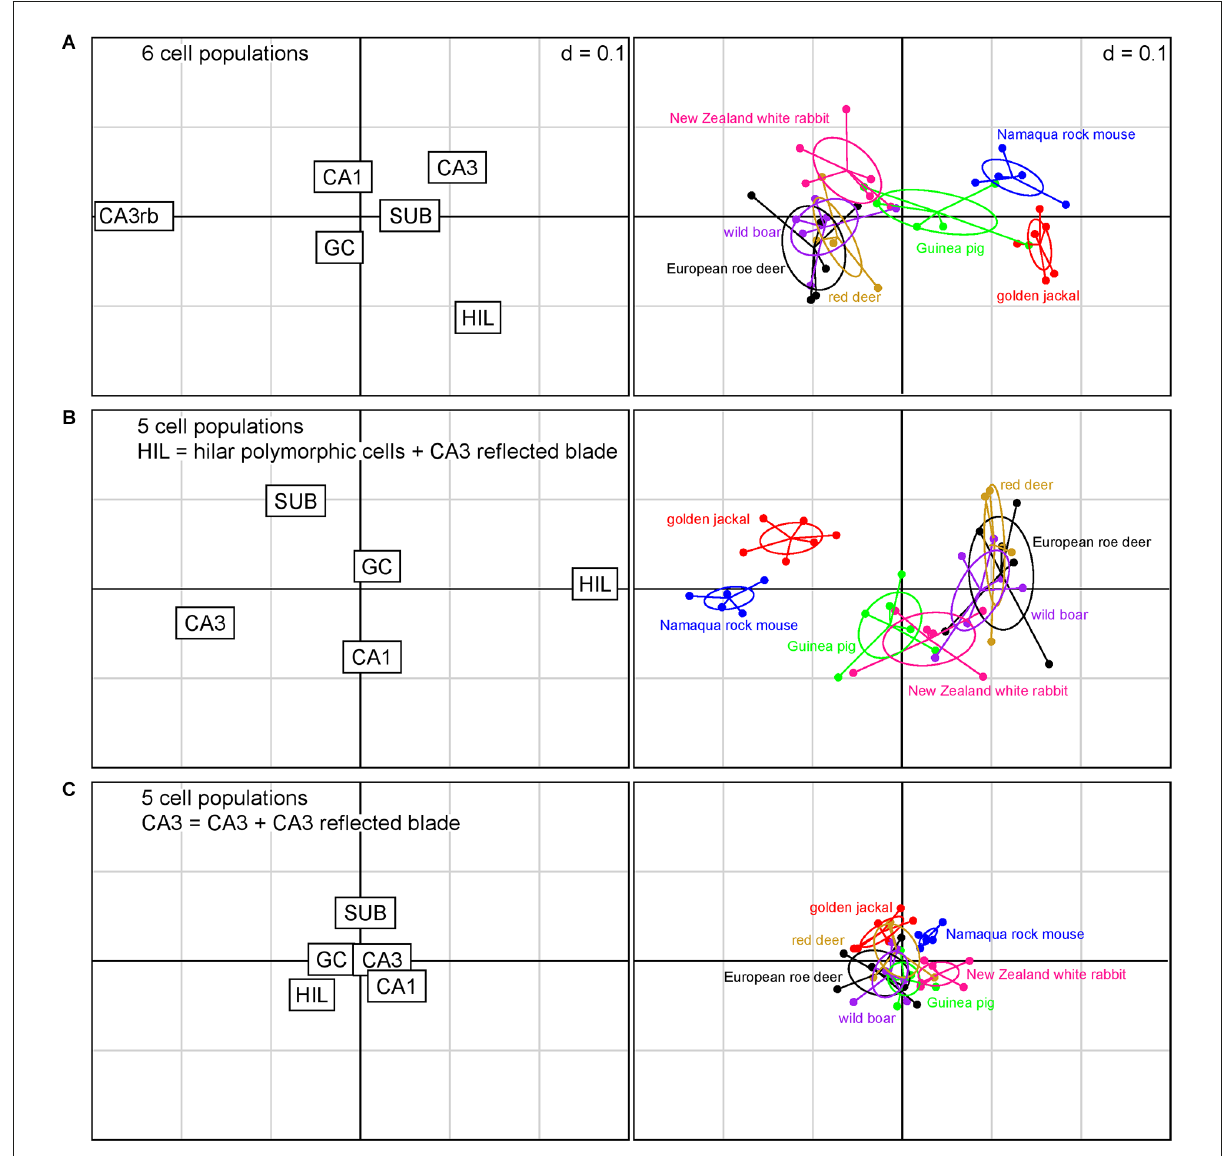
FIGURE3 Correspondence analysis showing the relationships between species based on quantitative relations between hippocampal principal cell numbers. The plots of hippocampal principal cell populations (left) show their power to separate species (right). (A) The six cell populations are presented independently. Cell numbers in the reflected blade (CA3rb) and the hilar polymorphic layer (HIL) are the strongest differentiators between species. (B) Reflected blade cells were added to the hilar cell population. Hilar and CA3 populations are the strongest differentiators. (C) Reflected blade cells are added to the CA3 pyramidal cell population. Species coalesce into a dense cluster as the differentiating power of all cell populations decreases. In this Figure and in Figure 4 , if the position of a species in the right graph is close to the position of a cell population in the left graph, the cell population will be large in that species. The position of a species will change as the relative sizes of the cell populations change the different